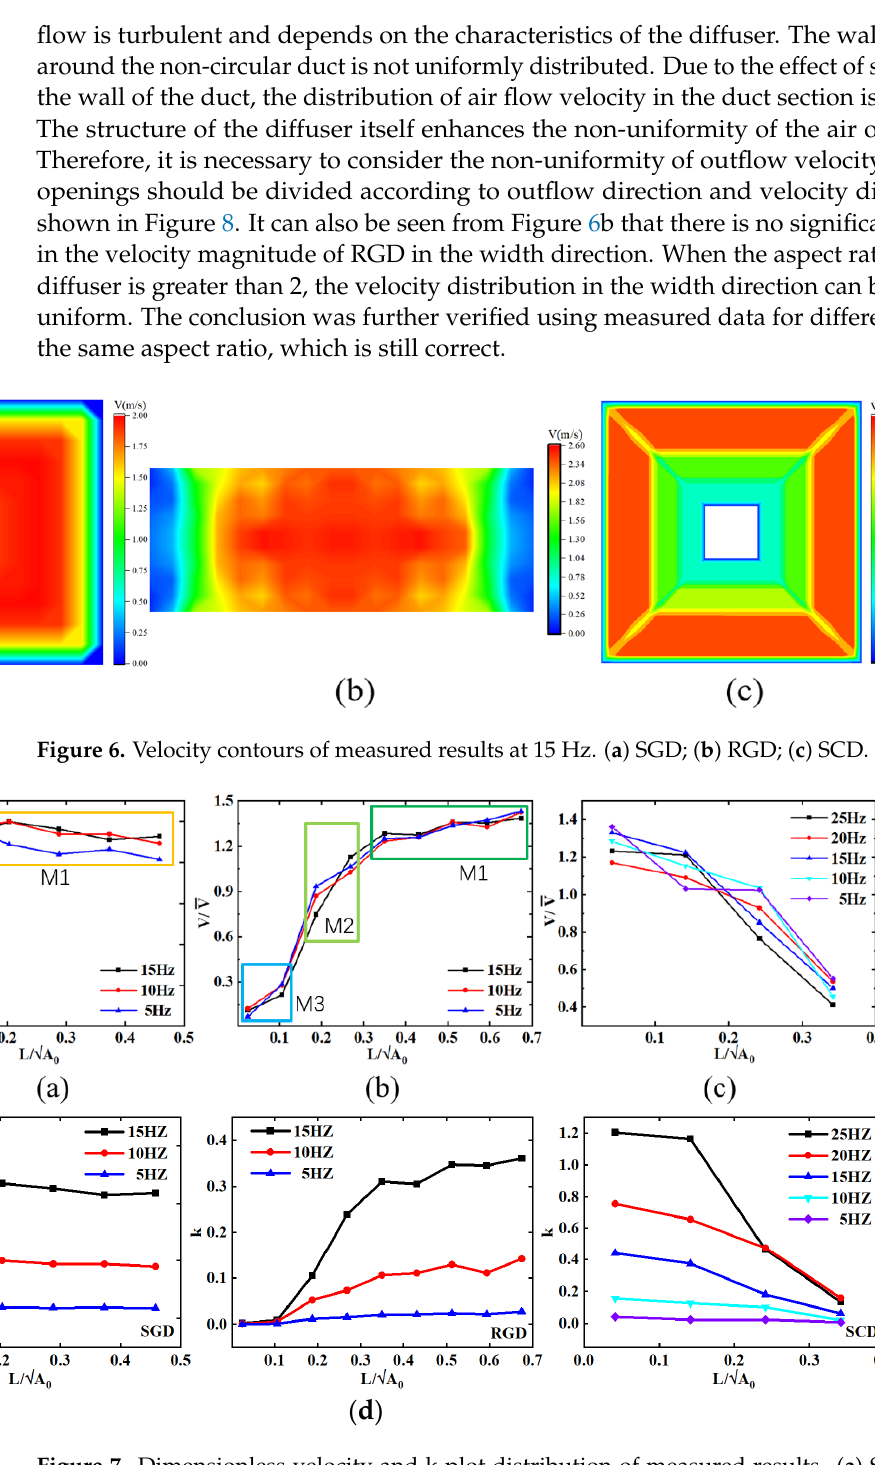
Figure 7. Dimensionless velocity and k plot distribution of measured results. ( a ) SGD; ( b ) RGD; ( c ) SCD; ( d ) k plots across the chosen diffuser plane.